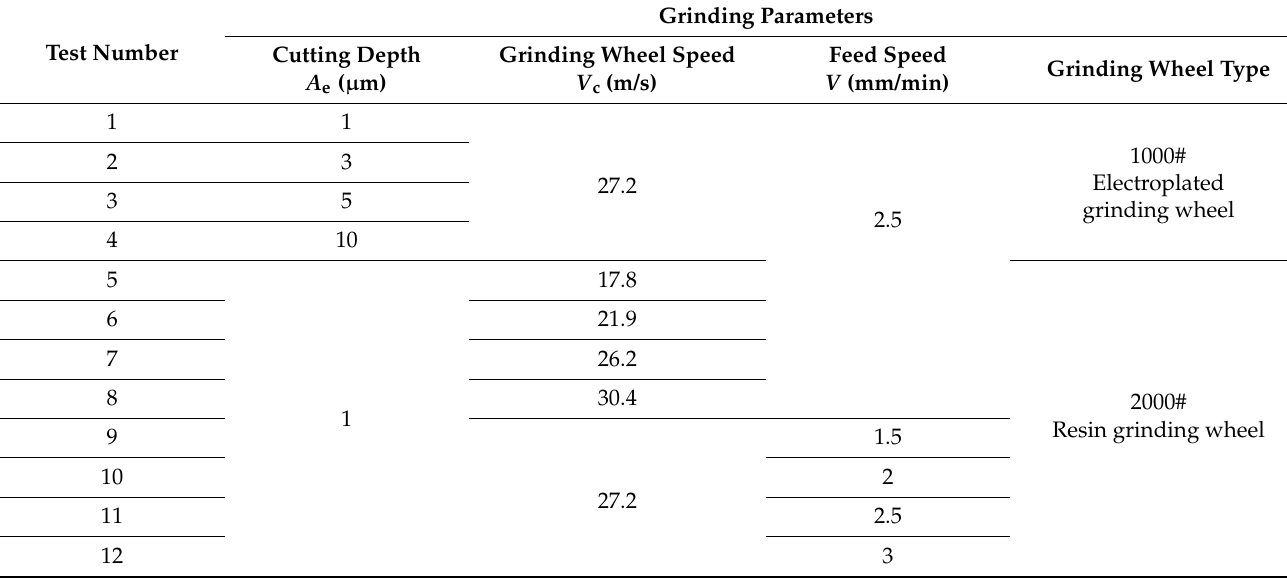
Table 2. Experimental parameters for single-factor grinding.